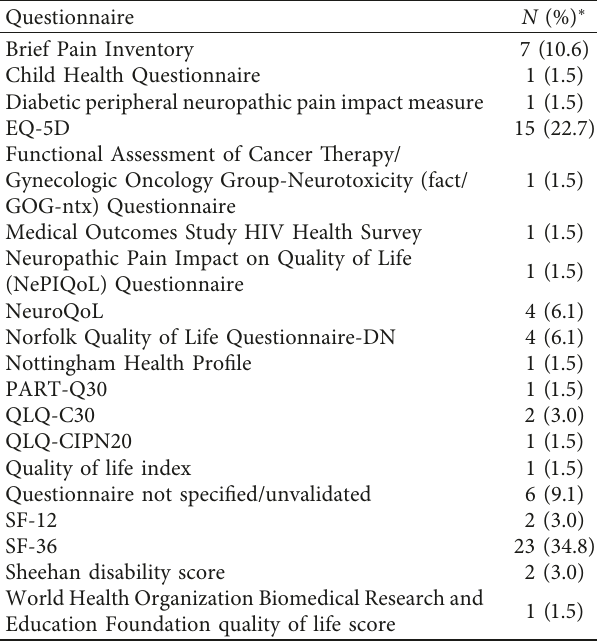
Table 2: Questionnaires used to assess quality of life.